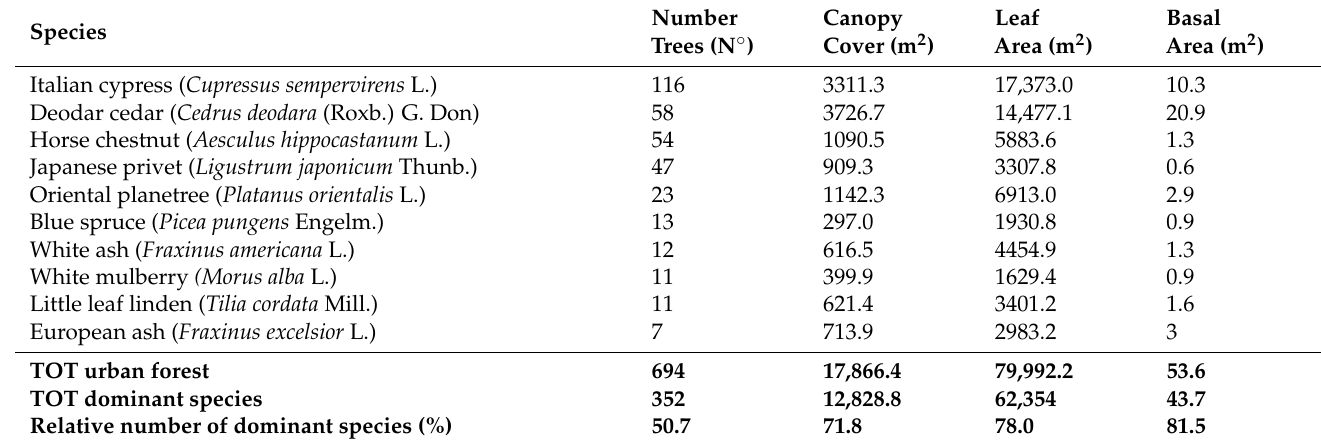
Table 2. Dominant species in EXPO Georgia park with a relative number, canopy cover, leaf area, and basal area at least 1%, 300 m 2 , 1000 m 2 , and 0.3 m 2 ,